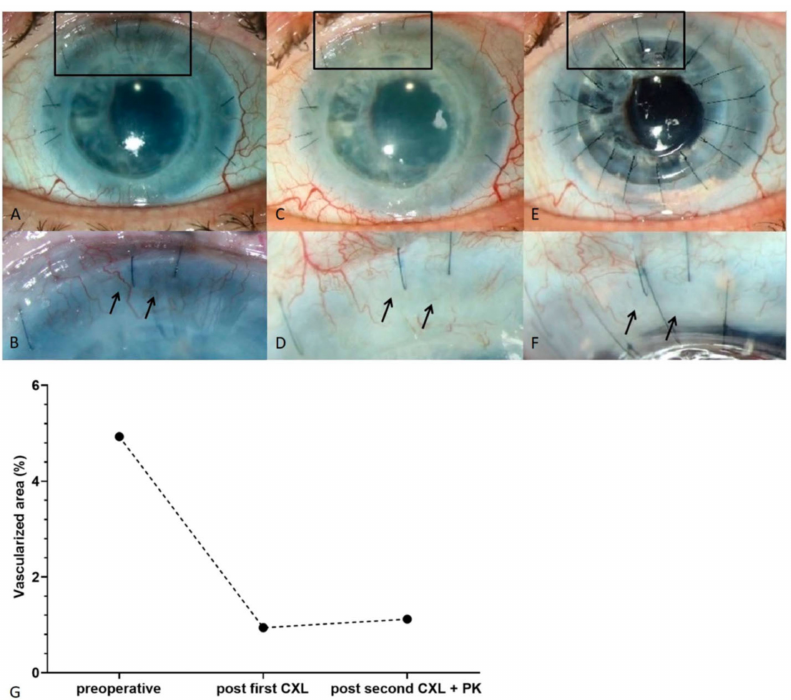
Figure 9. Angioregressive effect of isolated peripheral UVA-light based CXL in a high-risk cornea after 7 failed previous grafts. ( A ) vascularized cornea with marked corneal edema after failure of previous graft. ( B ) Magnification of insert in ( A ); arrows depict a stromal corneal vessel. ( C ) Three weeks after peripheral CXL excluding the limbal vascular arcade; significant regression of corneal neovasculariza- tion is observed. ( D ) Magnification of insert in ( C ); note that the blood vessel from ( B ) has disappeared (arrows). ( E ) Two weeks after second peripheral CXL combined with re-keratoplasty. Corneal blood vessels are still absent without revascularization, and the transplant is clear. ( F ) Magnification of insert in ( E ); the blood vessel is still absent (arrows). ( G ) Morphometric quantification of corneal blood vessels shows marked reduction of corneal neovascularization. From Schaub et al. 2018 [91].